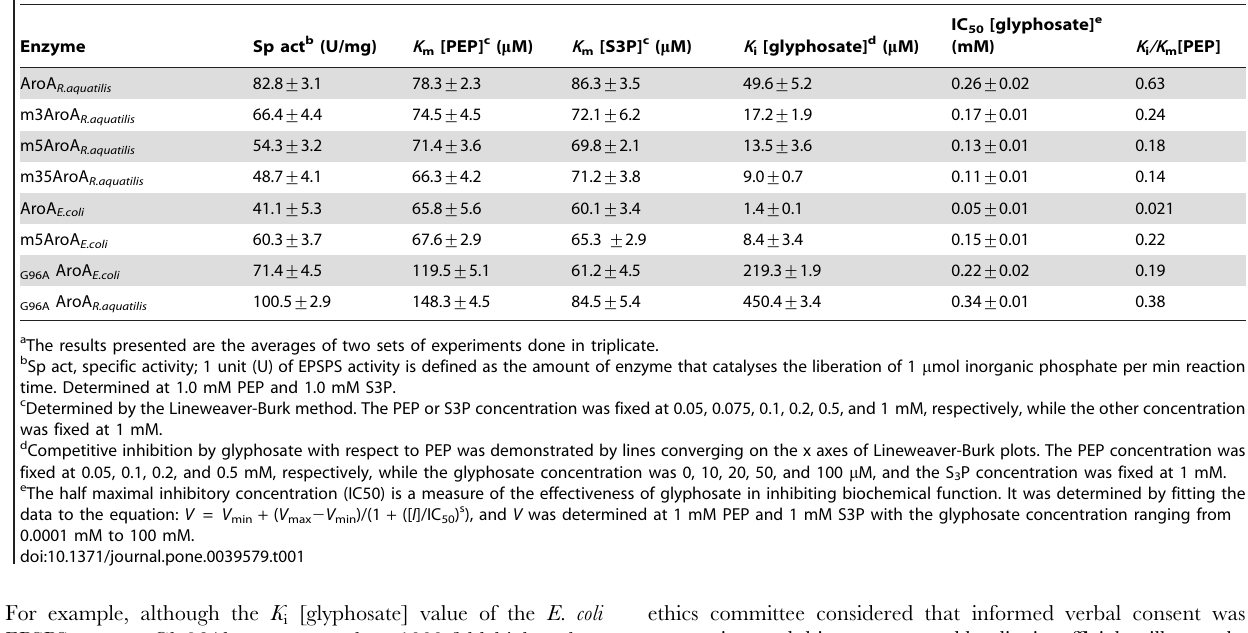
Table 1. Kinetic properties of AroA from R.aquatilis and E. coli. a